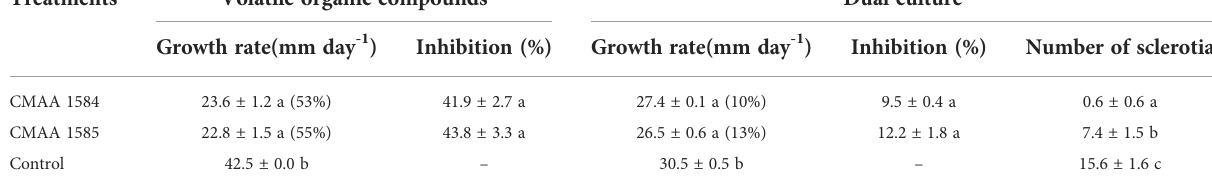
TABLE 2 Antagonistic activity of Trichoderma asperelloides CMAA 1584 and Trichoderma lentiforme CMAA 1585 against Sclerotinia sclerotiorum by dual culture test and production of volatile organic compounds (VOCs).